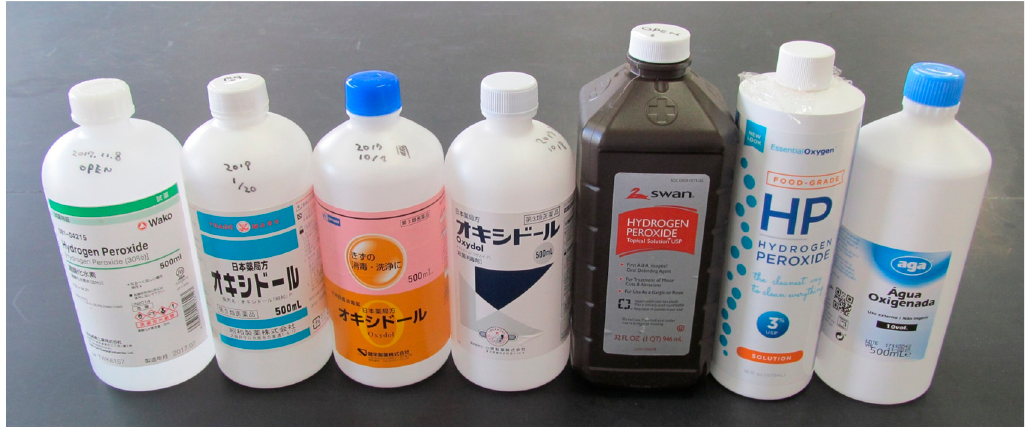
Figure 3. The analytical grade (Wako) and commercially available H 2 O 2 solutions used in this study. From left to right, Wako, Showa, Kenei, Kozakai, Swan, Essential Oxygen, and Álcool e Géneros Alimentares (AGA).